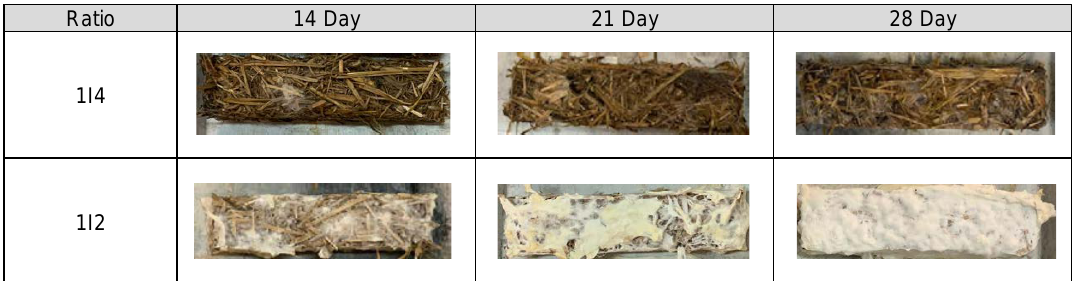
Table 5 Growth Observation of Samples of Different Mixing